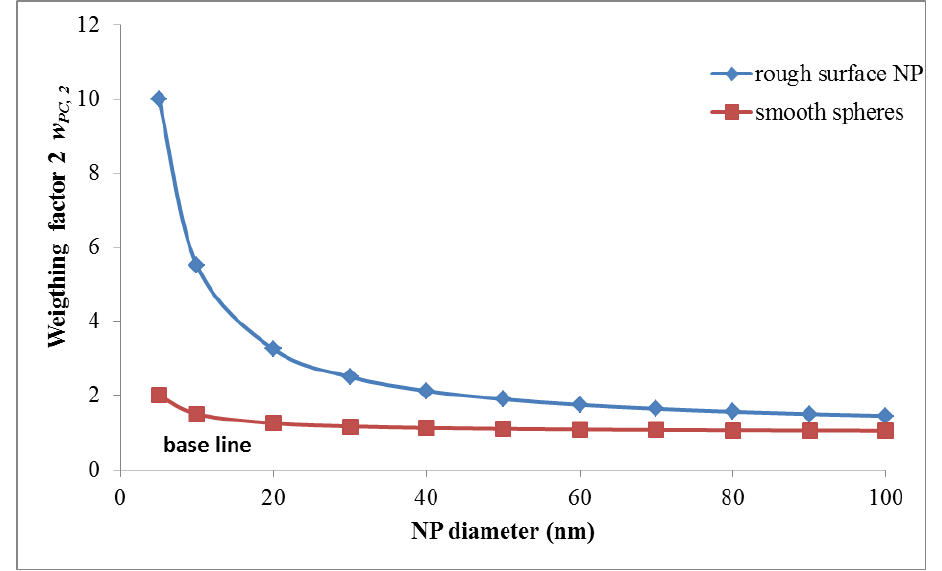
Figure 2. Weighting factor 2 ( w ) is proportional to the surface texture of NPs given as PC,2 relative roughness module: spherical NPs with smooth surface w PC,2 = 1 while w PC,2 is set to 10 for irregularly shaped NPs with sharp edges and ridges and a rough surface.